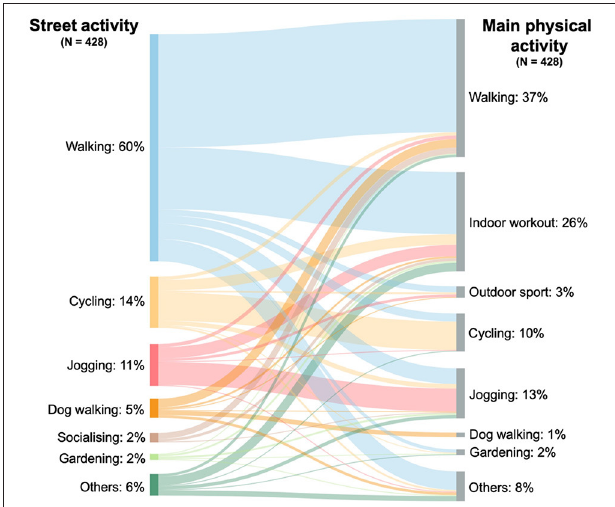
FIGURE 2 | Proportional distribution of activities identified by respondents ( N = 428) as their primary street activity (left side) and main physical activity (right side) during COVID-19. That is, the flow diagram directly links respondents’ answers of the question about primary street activity and main physical activity, and displays how the answer options overlap. “Others” includes commuting to work, shopping, household chores, and none. Further, 71% of respondents reported that they used streets for activities other than commuting to work ( Supplementary Table 1 ,